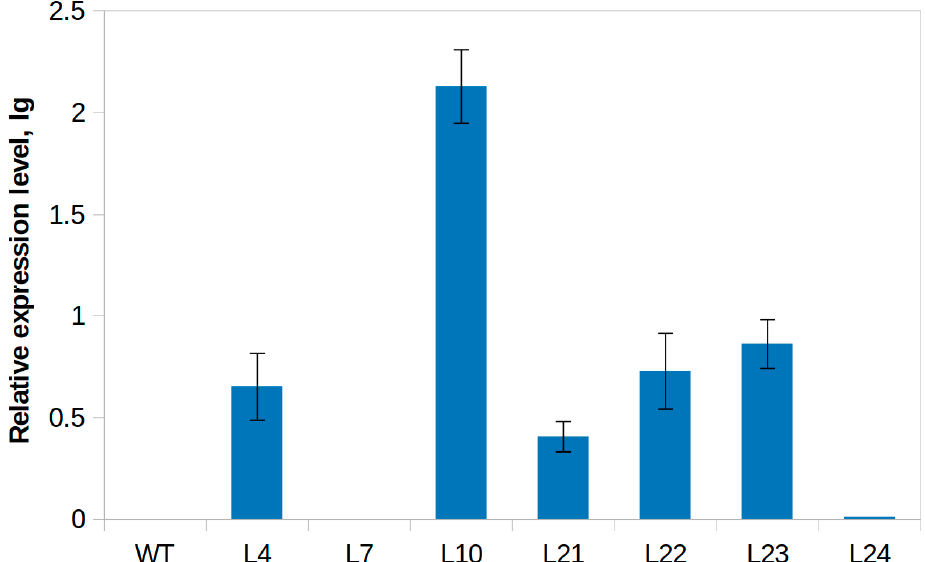
Figure 3. Expression level (in logarithmic scale) of the VlvSTS gene in the leaves of transgenic tobacco plants. WT—control tobacco, L4–L24 are transgenic tobacco lines with the VlvSTS gene. The gene of the elongation factor EF1 α was used as reference, the mRNA sample with the lowest transcription level (line L24) was used as calibrator.